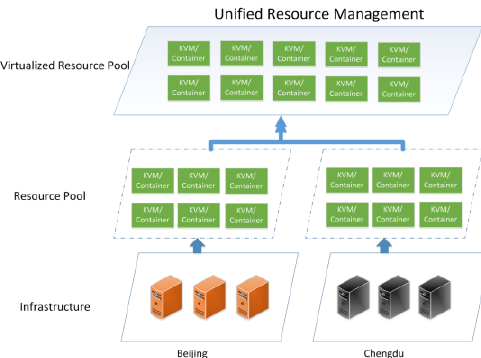
Figure 4. Unified resource management